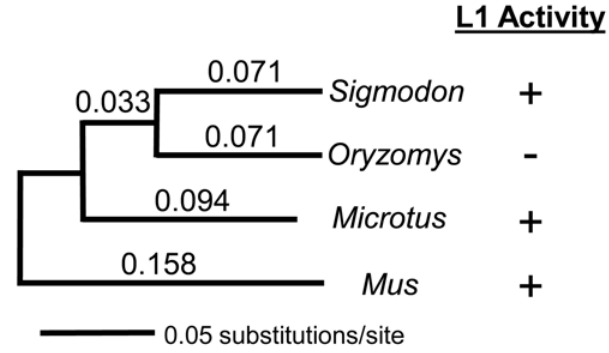
Figure 3. Phylogenetic analysis of Xist sequences from four rodent species. This maximum-likelihood tree was constructed using all ungapped characters that could be unambiguously aligned. Branch lengths are listed. The column on the right indicates whether each species shows L1 activity.